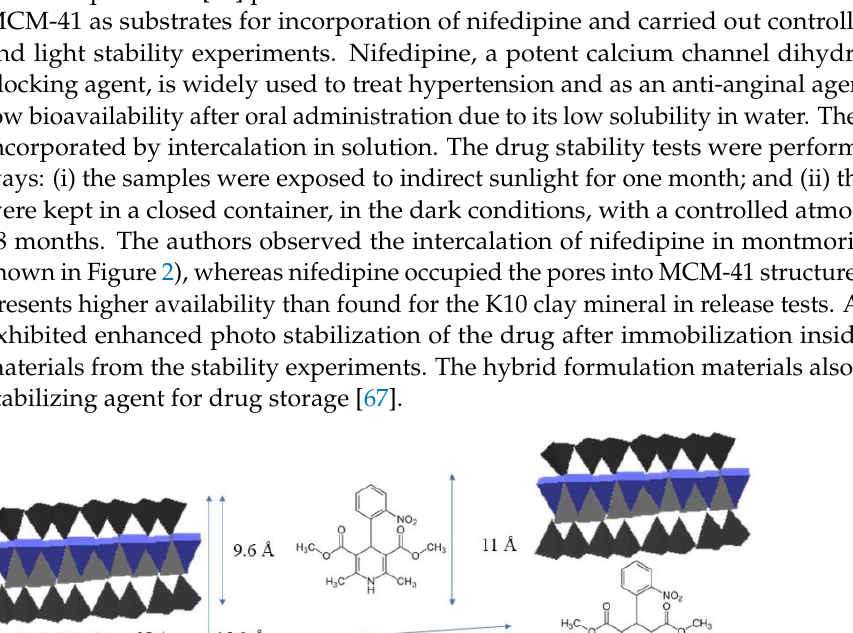
Figure 3. Scheme of nifedipine-loaded halloysite for study of photostability by Yendluri et al. 2017. Adapted with permission from ref. [68]. 2022, Elsevier. Tetracycline is one of the most used antibiotics because of its low cost, broad-spec- trum, and antimicrobial properties. However, tetracycline can absorb light and cause pho- tosensitivity due to the formation of photoproducts after exposure to light [69]. A study by da Rocha et al. [69] evaluated the photoprotection potential of tetracycline incorporated in different clay minerals. Tetracycline in an aqueous solution was incorporated into montmorillonite, sepiolite, and palygorskite. The photocatalytic tests placed 2 g of each hybrid on scattered glass plates to obtain a material layer with thickness below 1 – 2 mm. The samples were exposed to a mercury vapor lamp as a source of UV radiation up to 200 h. From the thermal analysis results, high incorporations of tetracycline and higher ther- mal stability in the structures of the studied clay minerals were observed. Furthermore, photostability tests indicated that the tetracycline adsorbed into clay structures was not easily degraded by UV irradiation, especially in the lamellar clay minerals.